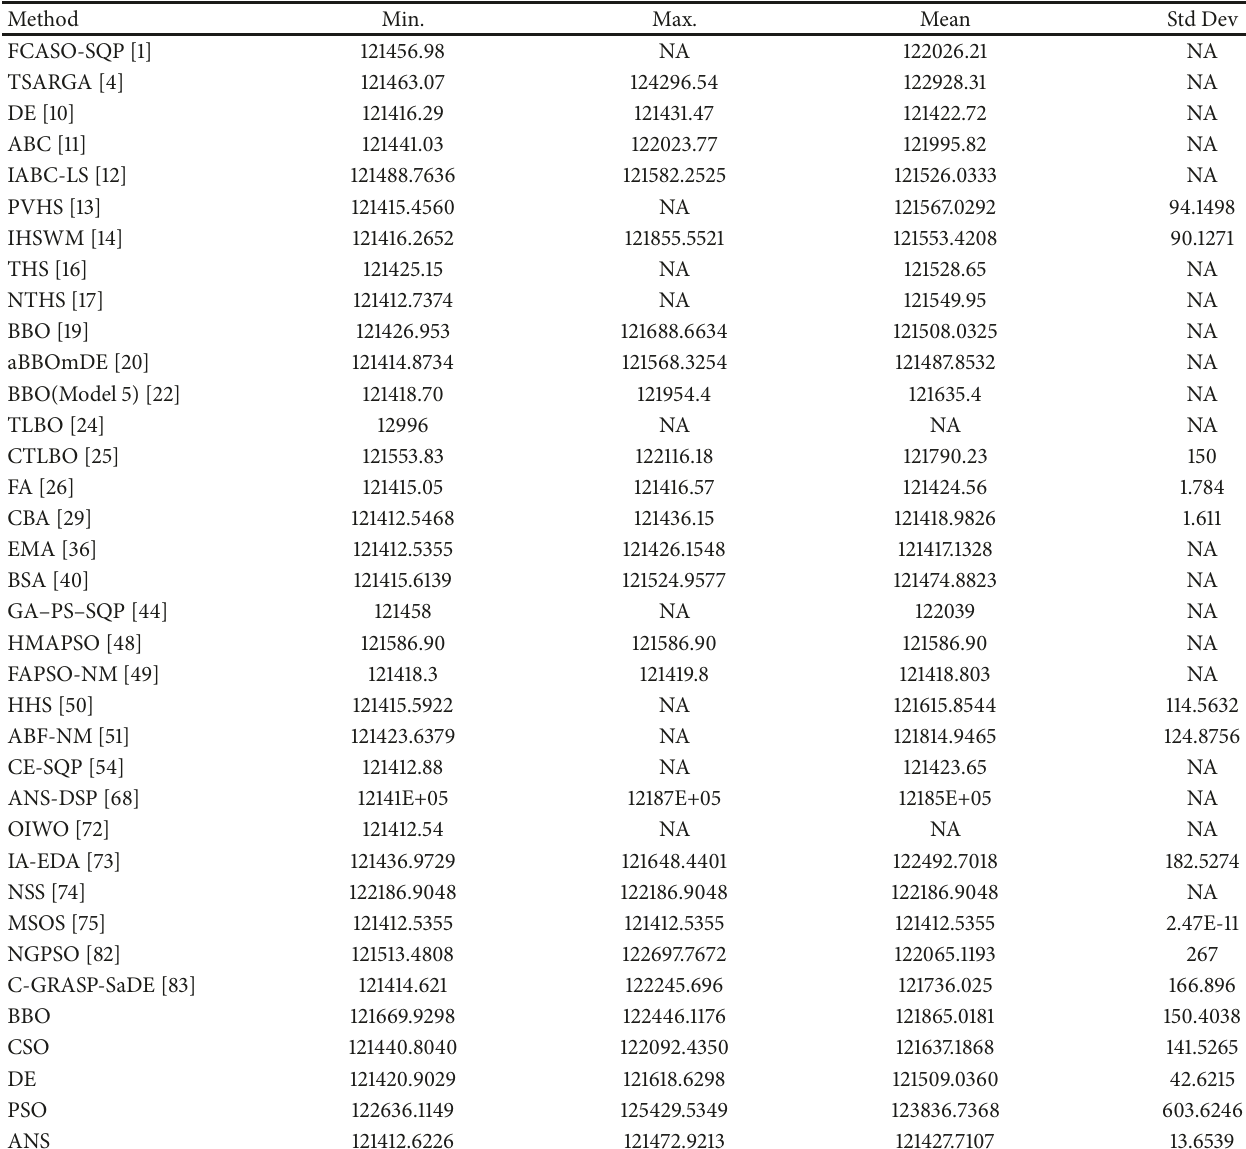
Table 5: Comparison of simulation results ($/h) for 40-generator system (Case